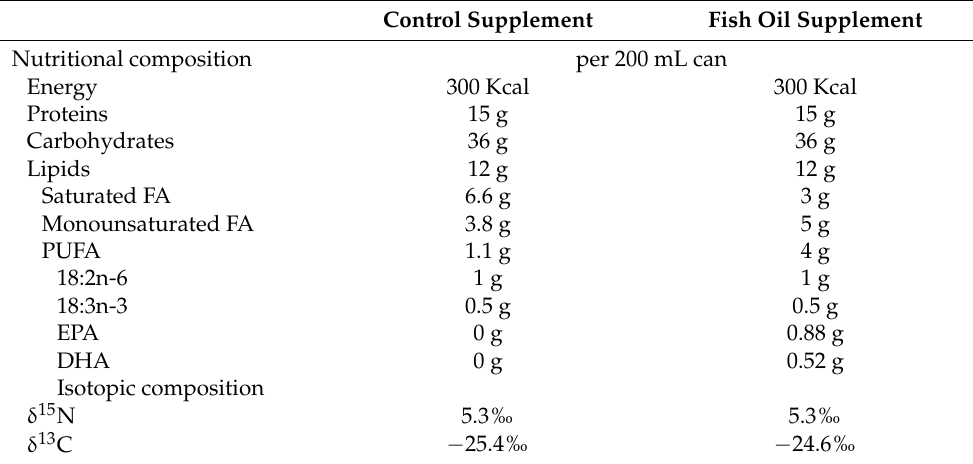
Table 1. Nutritional and isotopic compositions of the fish oil and control